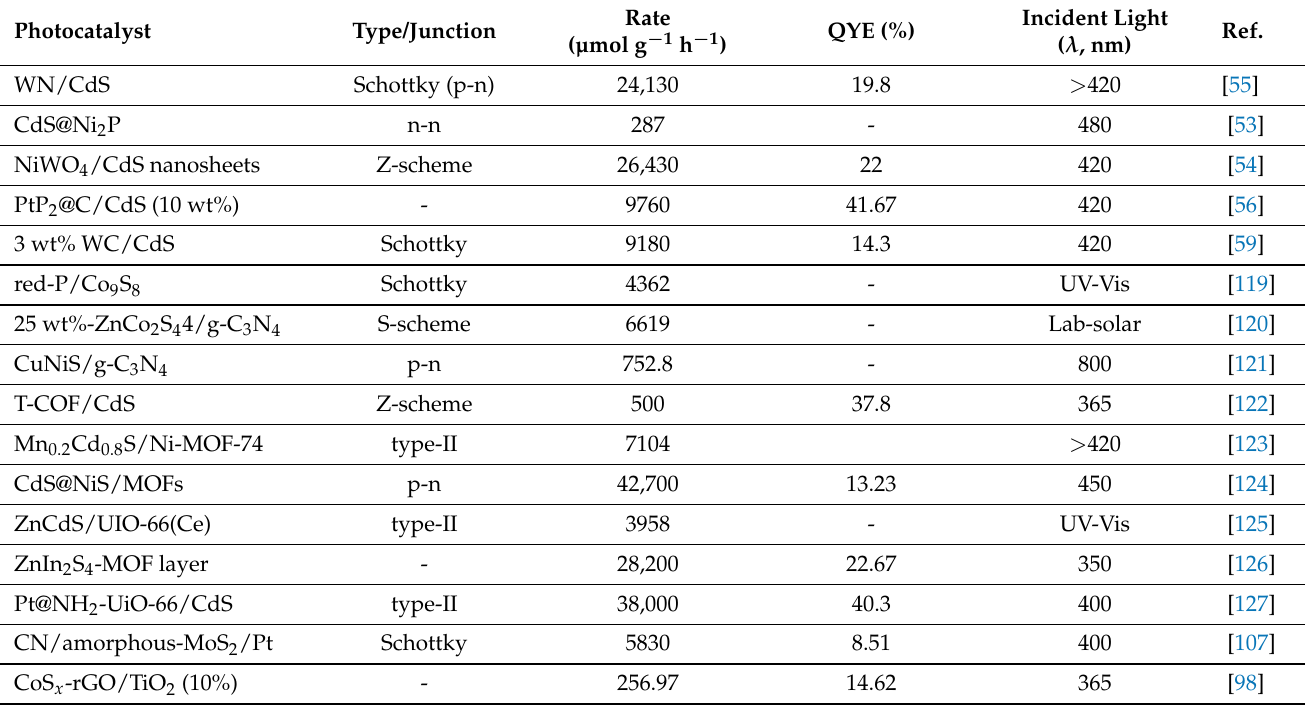
Table 1. Summary of recently reported metal sulfide based photocatalysts with improved efficiency for the H 2